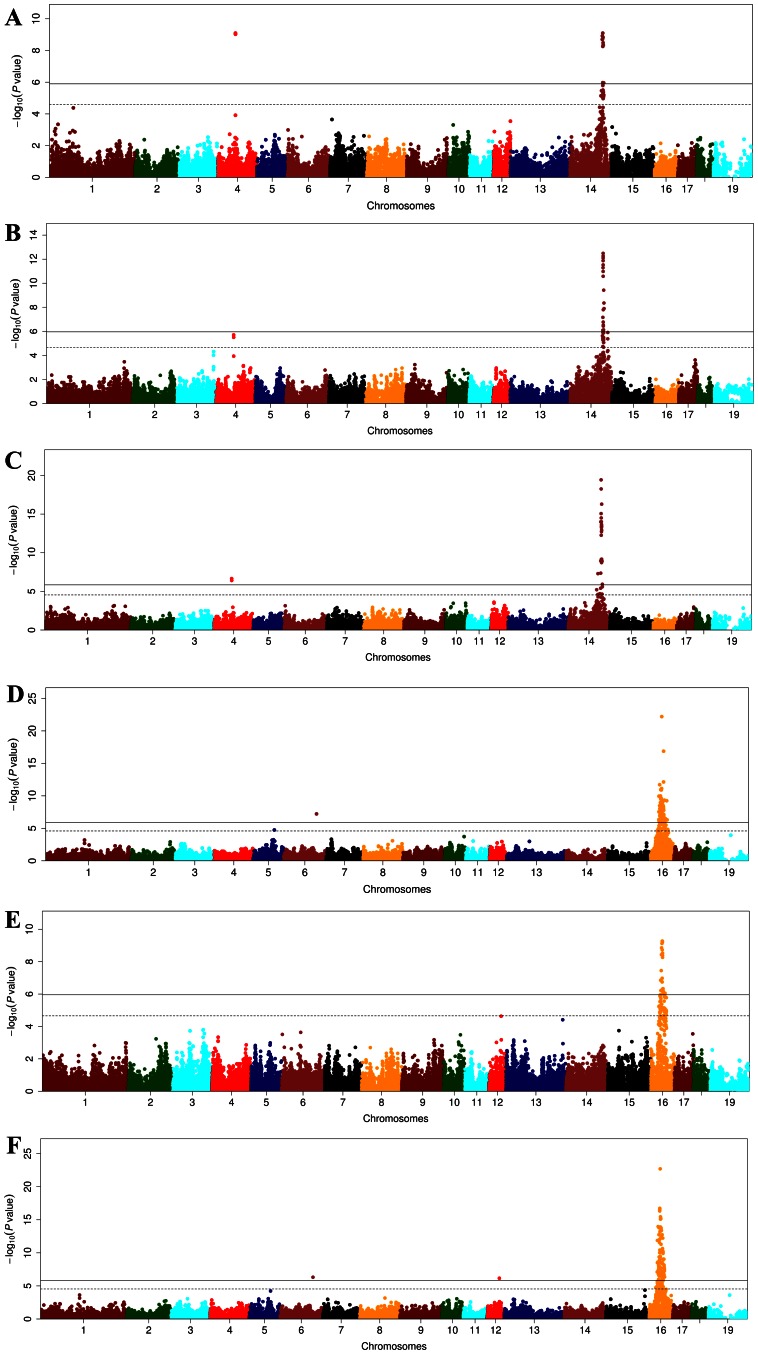
Manhattan plots for the analyses of muscle C18∶0 and C20∶0.(A–C) The first round of GWAS for C18∶0 in F2 (A) and Sutai (B) pigs and the meta-analysis of F2 and Sutai samples (C). (D–F) The first round of GWAS for C20∶0 in F2 (D), Sutai (E) and the meta-analysis of F2 and Sutai samples (F). In the Manhattan plots, negative log10
P values of the qualified SNPs were plotted against their genomic positions. The SNPs on different chromosomes are denoted by different colors. The solid and dashed lines indicate the 5% genome-wide and suggestive Bonferroni-corrected thresholds, respectively.